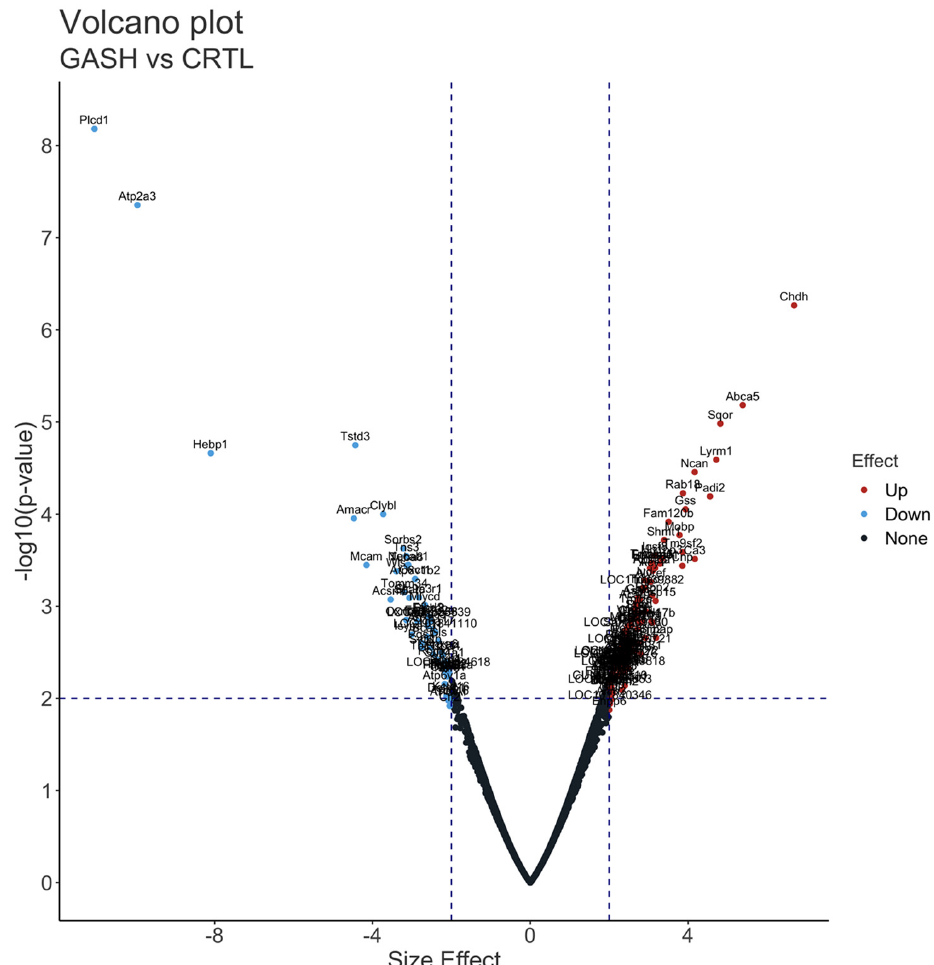
Figure 3. Volcano plot of DEPs. The X -axis of the graph is the Cohen’s effect size, and the Y -axis is the corresponding − log10 ( p -value). The red dot indicates significantly up-regulated proteins, the blue dot indicates significantly down-regulated proteins in the IC of the GASH/Sal vs. control hamster, and the black dots indicate proteins without significant change. The gene names that encode the significant proteins are shown on the graph, and for better visualization, an interactive version of Figure 3 is provided in the Supplementary Material